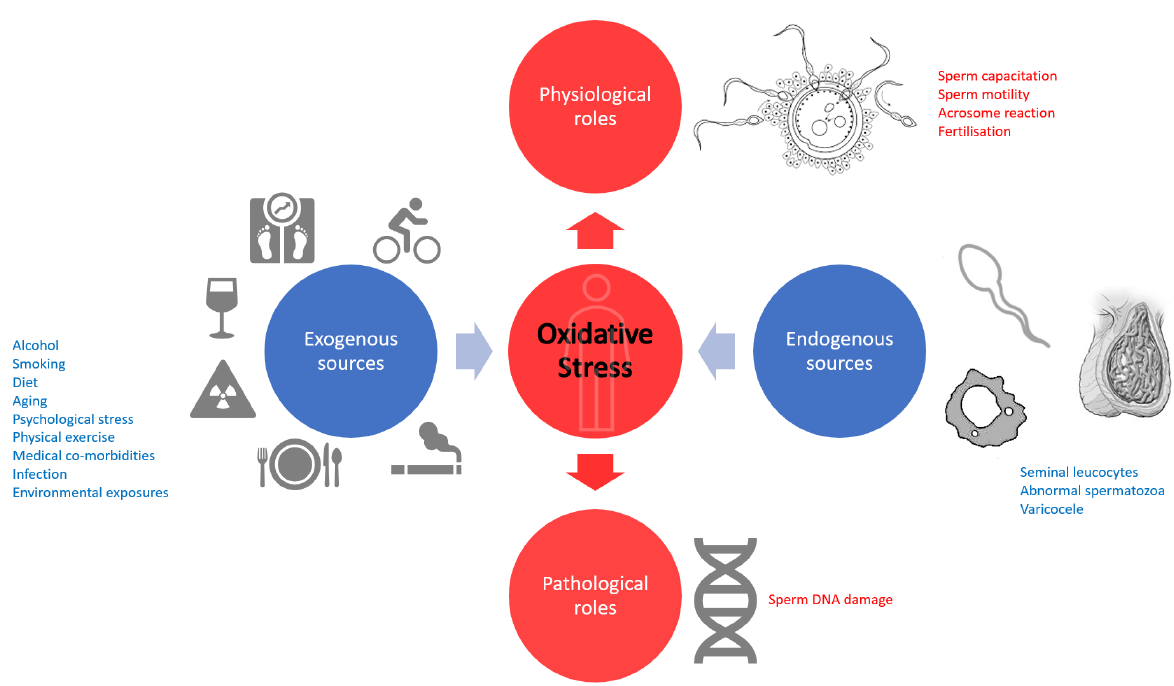
Figure 1. A schematic of example sources and roles of seminal oxidative stress.